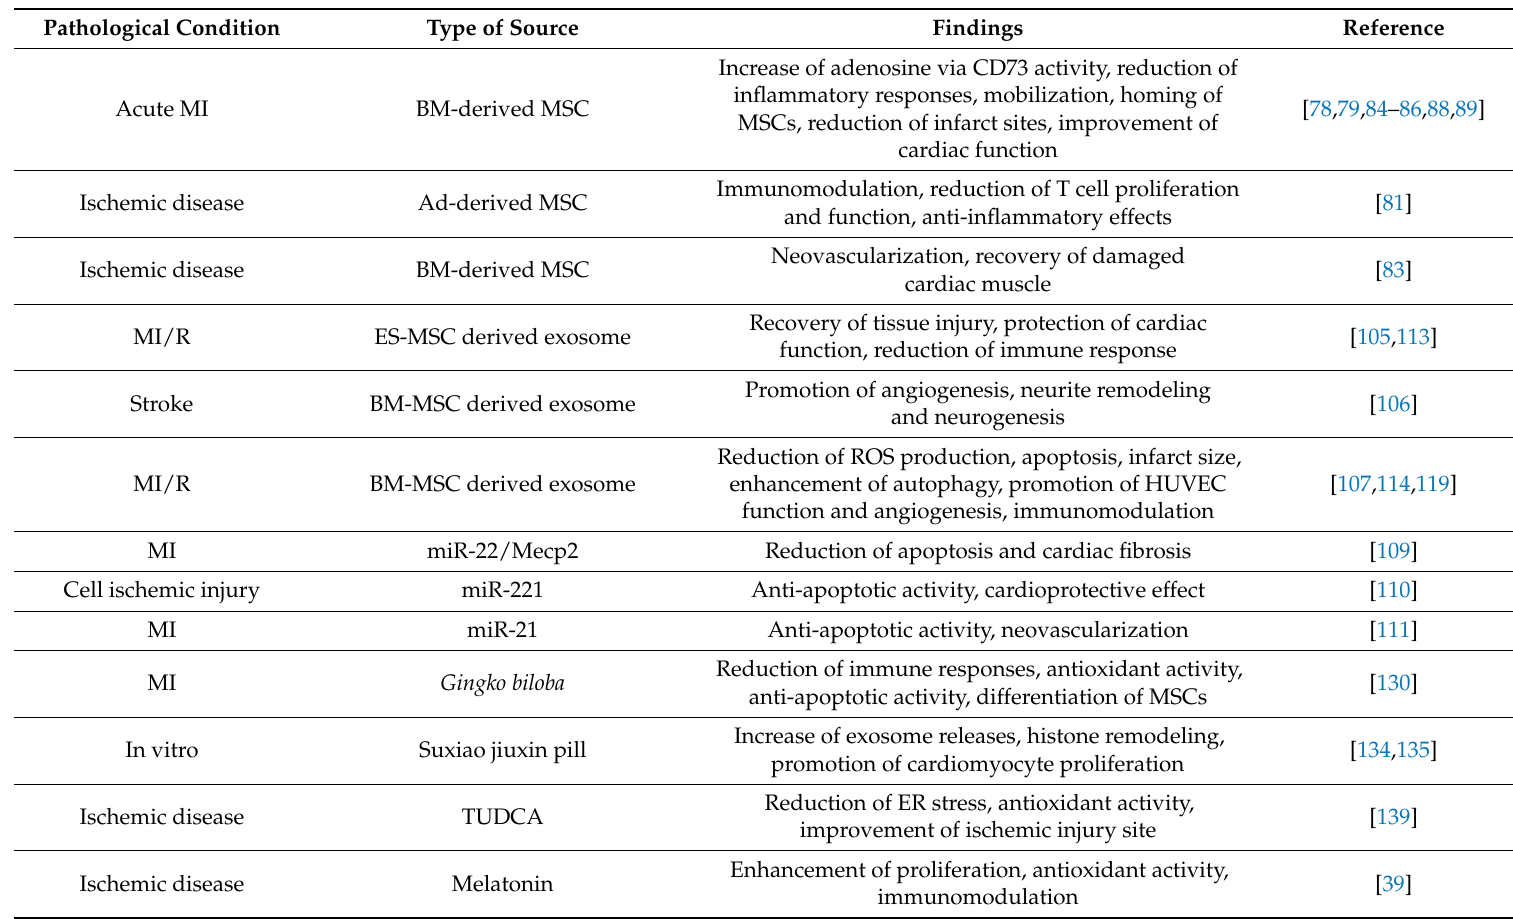
Table 1. A summary of the effects of MSCs in the treatment of